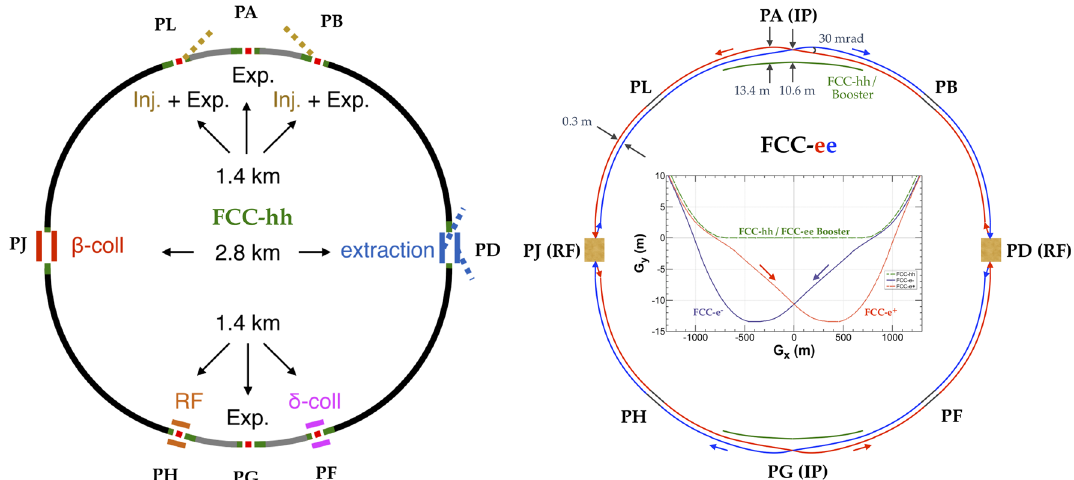
Fig. 2.1 The layouts of FCC-hh (left), FCC-ee (right), and a zoom in on the trajectories across interaction point G (right middle). The FCC- ee rings are placed 1 m outside the FCC-hh footprint in the arc. The e + and e − rings are separated by 30 cm horizontally in the arc. The main